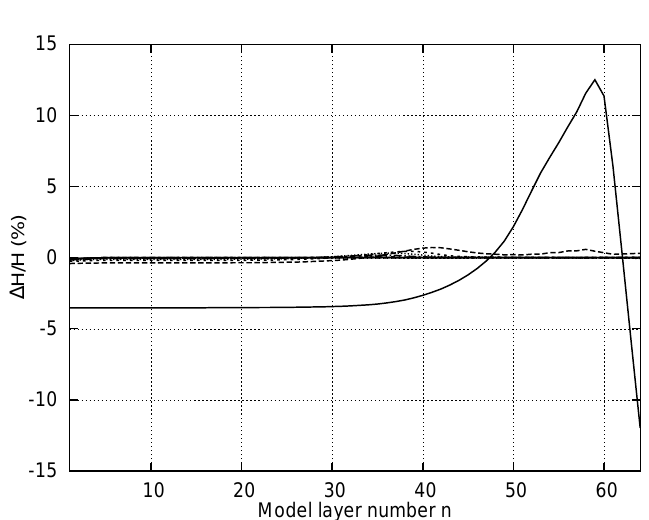
Fig. 2. The relative initial stellar model atmosphere flux (solid line) and its consequent iterative improvement by the Broyden loop steps (in %). The first correction is obtained using the Jacobian, computed by the Levenberg-Marquardt method and improving it by iterations of the Broyden loop. The model parameters: T eff = 16 000 K, log g = 4.